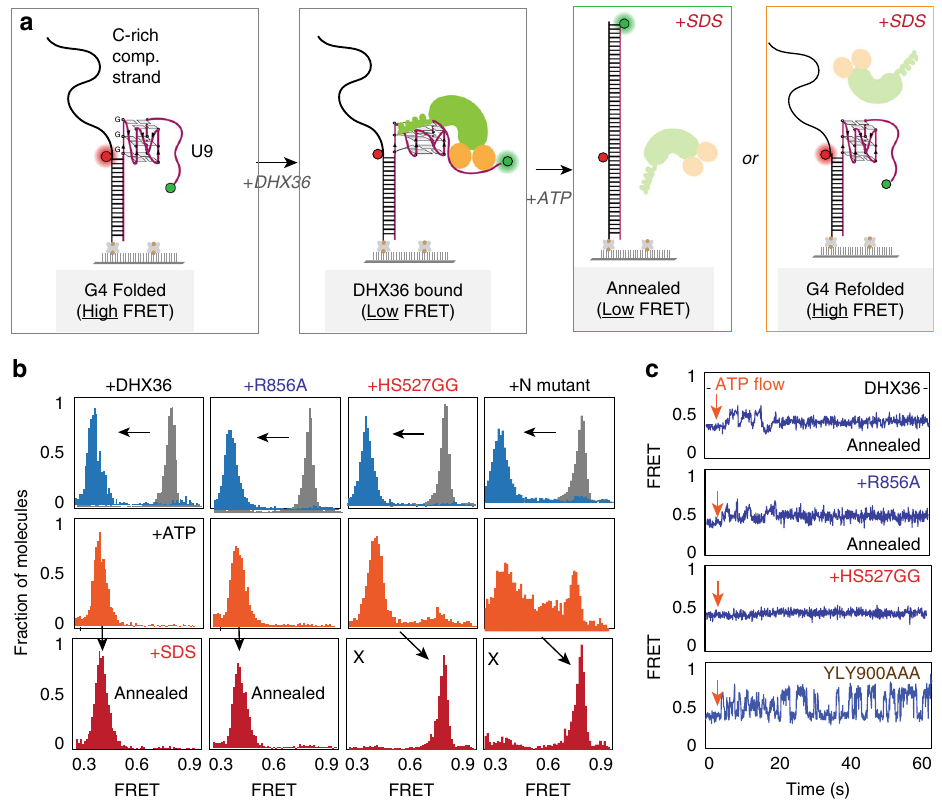
Fig. 6 Annealing of G4 to complementary cis-strand depends on successful unfolding of G4. a Schematic of cis -annealing assay. ATP-dependent G4 resolving activity of DHX36 may result in annealing or refolding of G4. b FRET histograms taken at RNA-only (gray), DHX36-bound (blue), ATP added (orange) and SDS applied (dark red) for DHX36 and three mutants. c smFRET traces taken for each